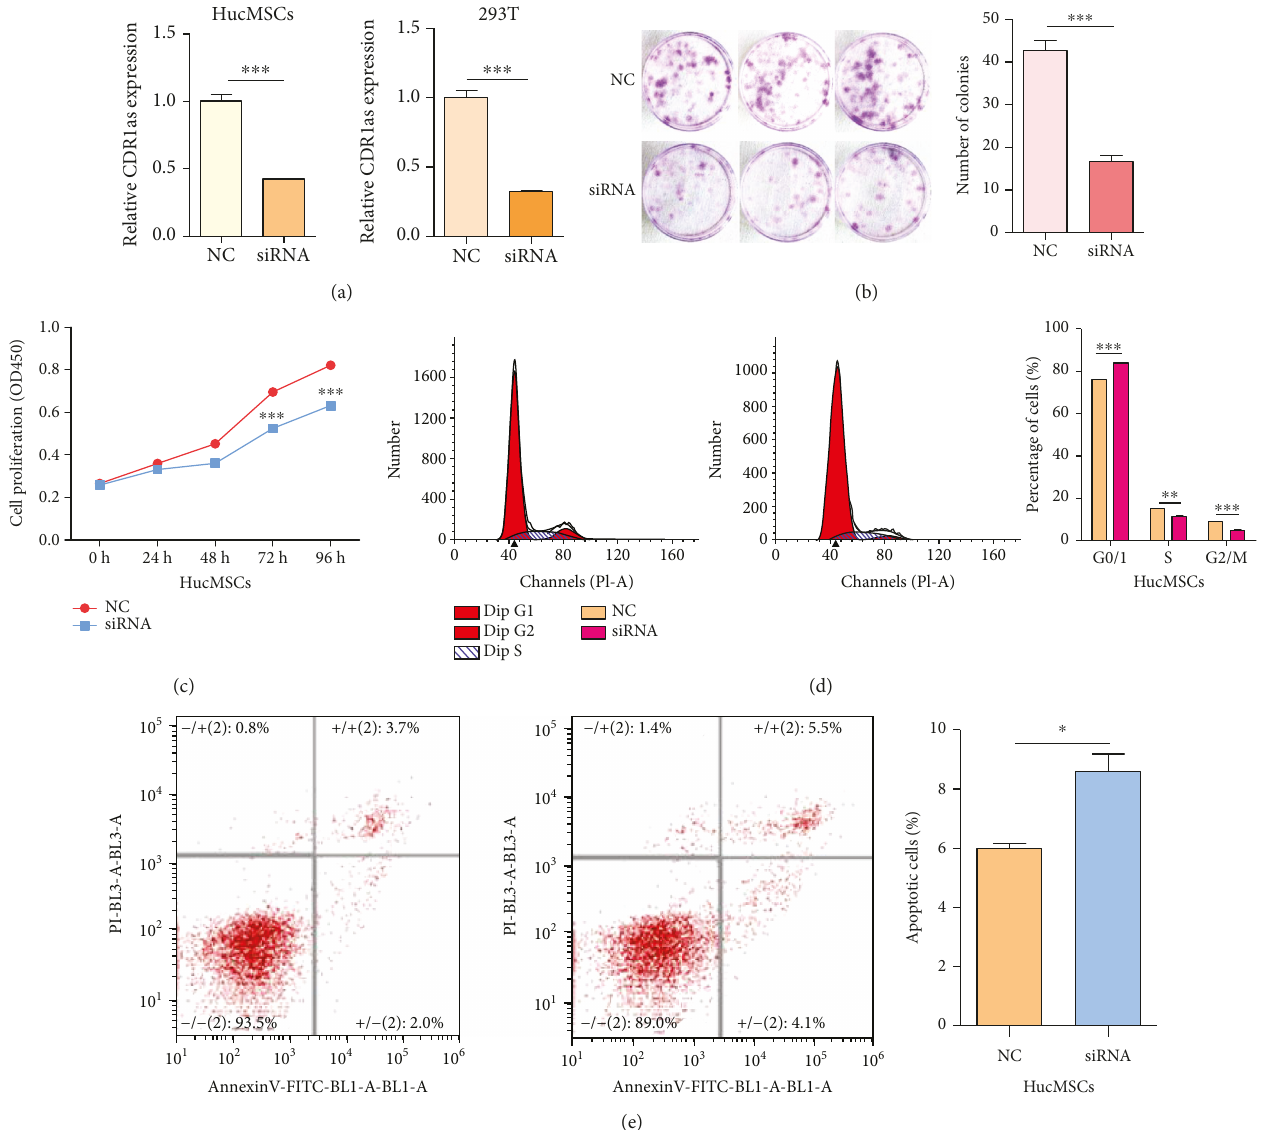
Figure 3: Knockdown of CDR1as inhibited cell proliferation and induced cell apoptosis. (a) The knockdown e ffi ciency of CDR1as in hucMSCs and 293 T cells. (b) Colony-forming assay of hucMSCs transfected with siRNA of CDR1as or negative control. (c, d) CCK-8 and cell cycle assay of hucMSCs transfected with siRNA of CDR1as or negative control to evaluate cell proliferative ability. (e) Flow cytometry apoptosis analysis of hucMSCs transfected with siRNA or control. ∗ P < 0 05 ; ∗∗ P < 0 01 ; ∗∗∗ P < 0 001